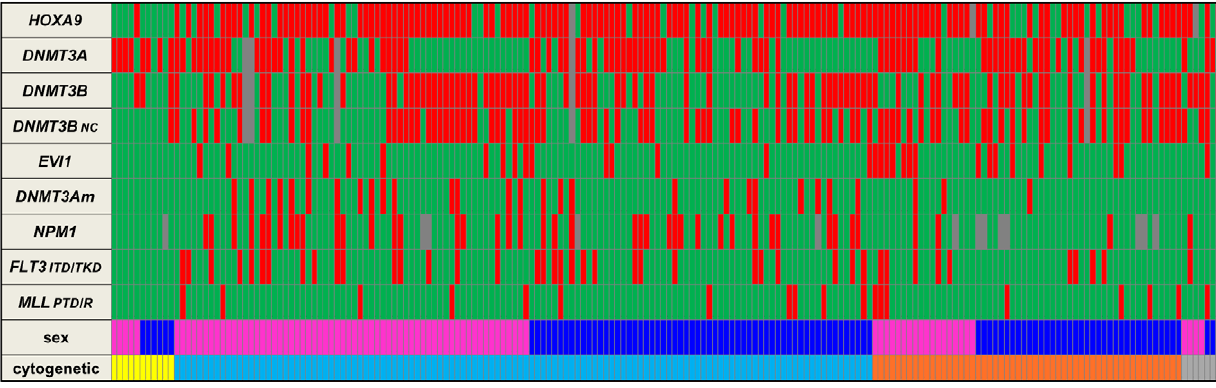
Figure 1. Genetic profile of each patient according to cytogenetic subgroups. Horizontal lines represent molecular markers, (red: mutated or overexpressed; green: wild-type or normal expression level; grey: not available data). One individual patient (195) in each column according to their cytogenetic subgroup (yellow: favourable karyotype; blue: intermediate karyotype; orange: unfavourable karyotype; grey: failed karyotype) and their gender (pink: female; dark blue: male).